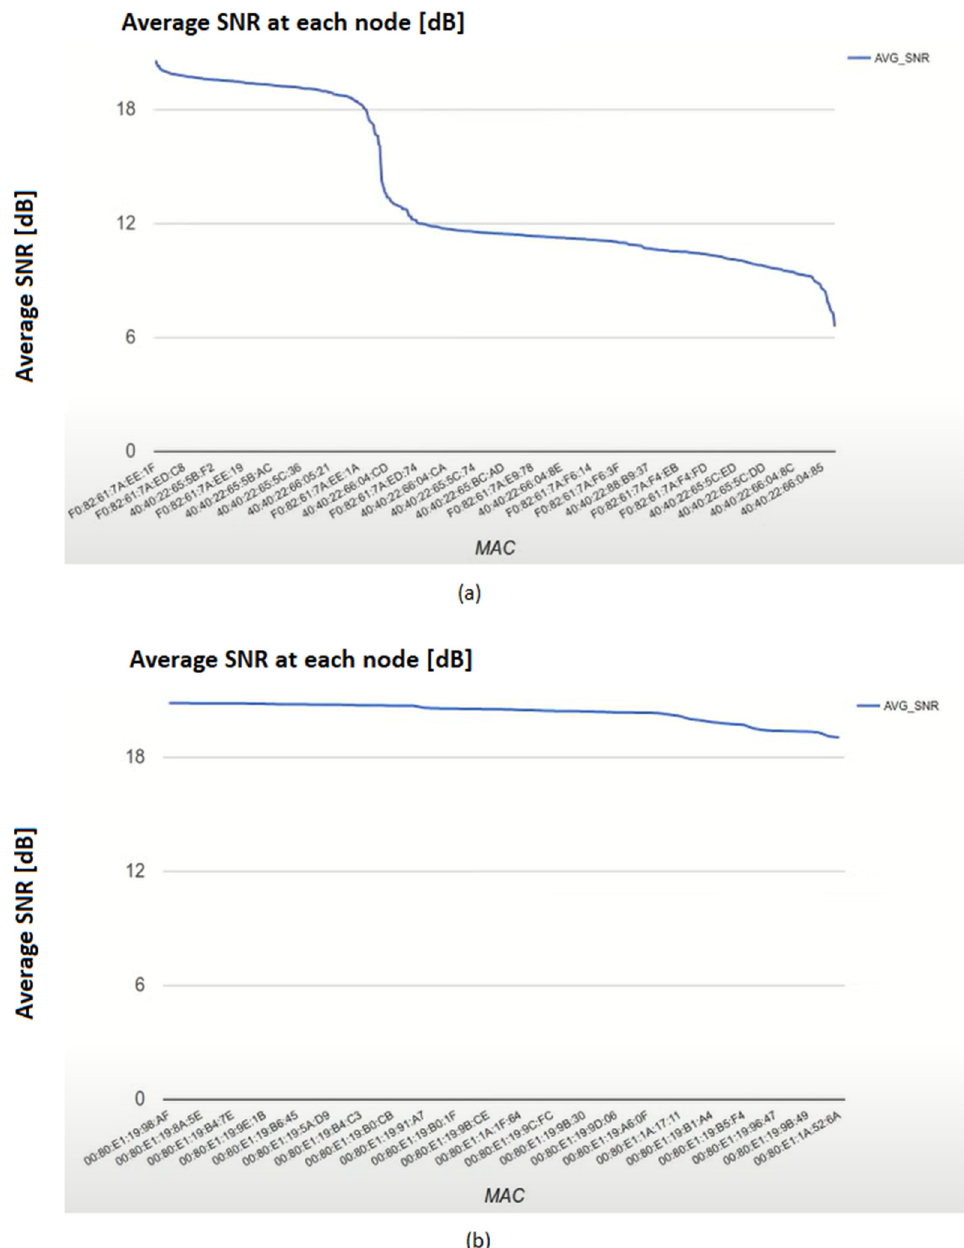
Figure 14. Graphs of average SNR for ( a ) a problematic scenario and ( b ) a non-problematic scenario.